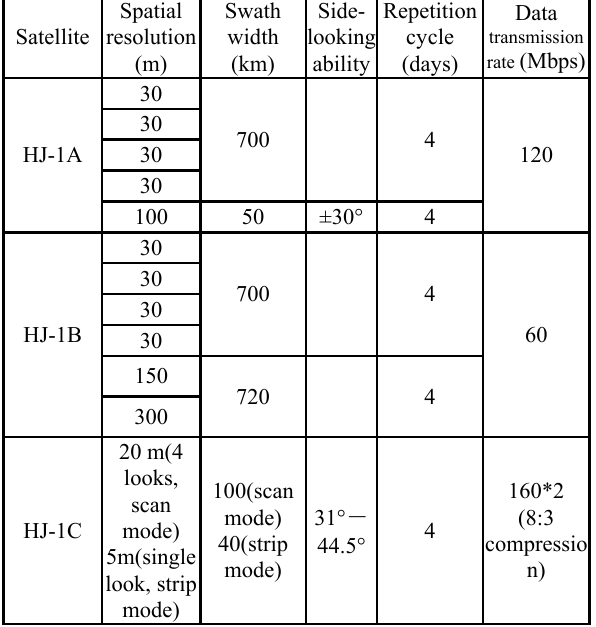
Table 1.Technical specification of payloads of HJ-1A/1B